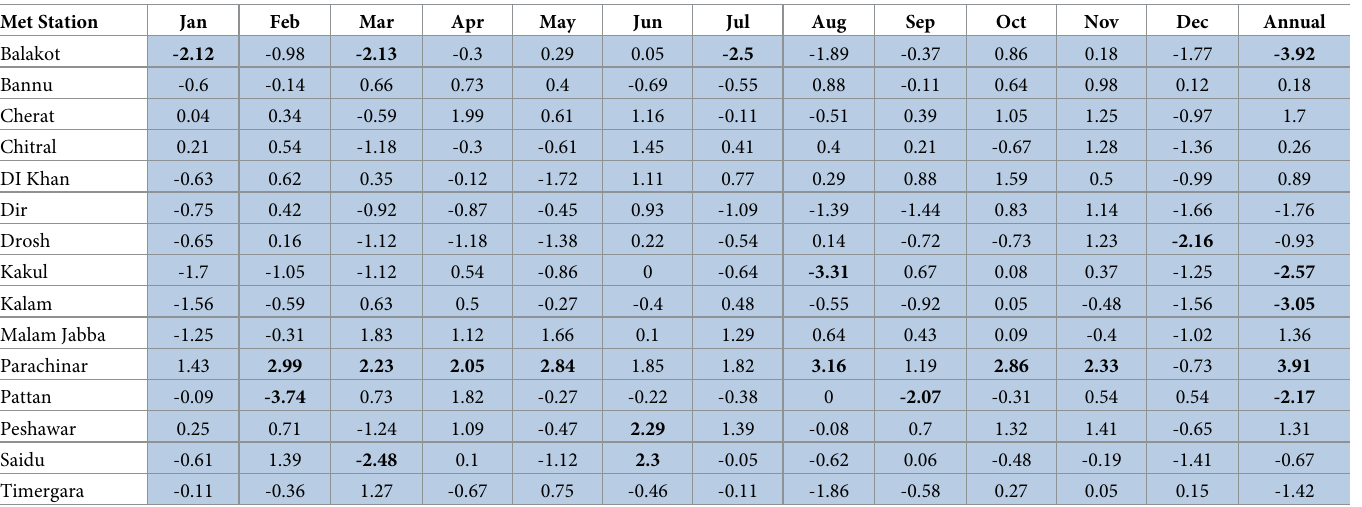
Table 3. Spatial distribution of Spearman’s Rho Z value for monthly and annual